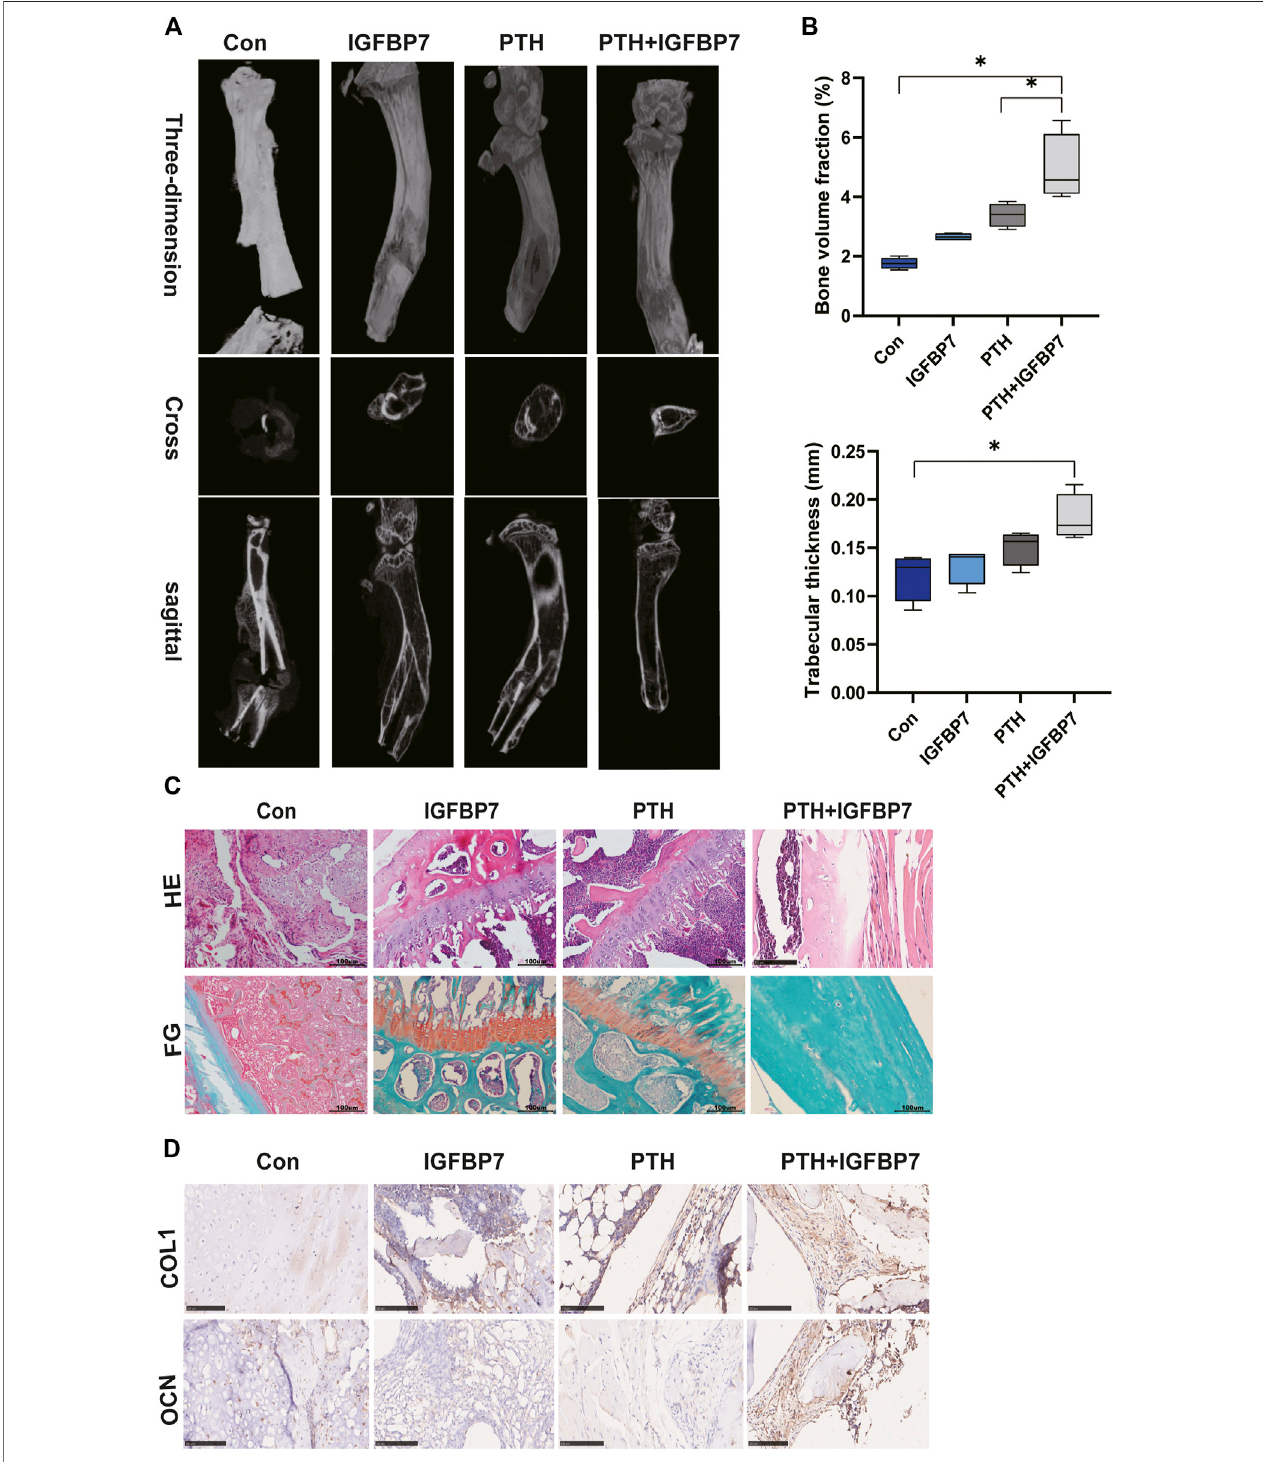
FIGURE6| IGFBP7combinedwithPTHenhancesbonehealinginamousefracturemodel. (A) Imagesofthebonedefectsitesdetectedbymicro-CTscanning. (B) Bonevolumefractionandtrabecularthicknesswereanalyzed.* p < 0.05. (C) Histologicalanalysisforbonehealing,H&E;fastgreenandSafraninstaining,FG;Scalebars, 100 μ m. (D) Immunohistochemical staining for COL1 and OCN in bone healing sites; Scale bars, 100 μ m.